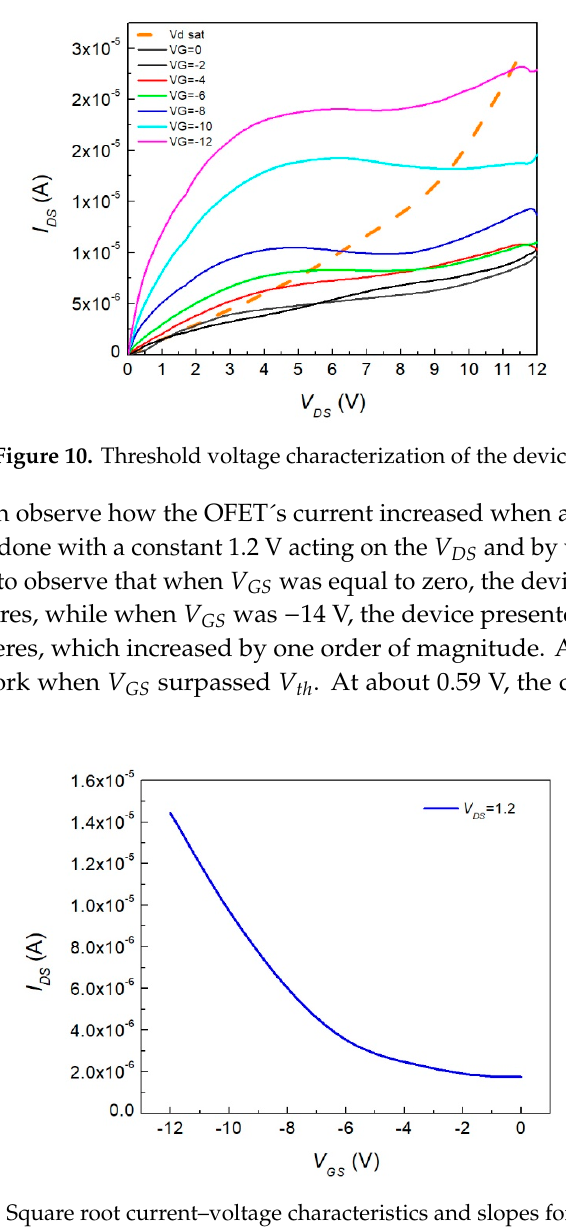
Figure 9. Flexible OFET output and current–voltage characteristics.